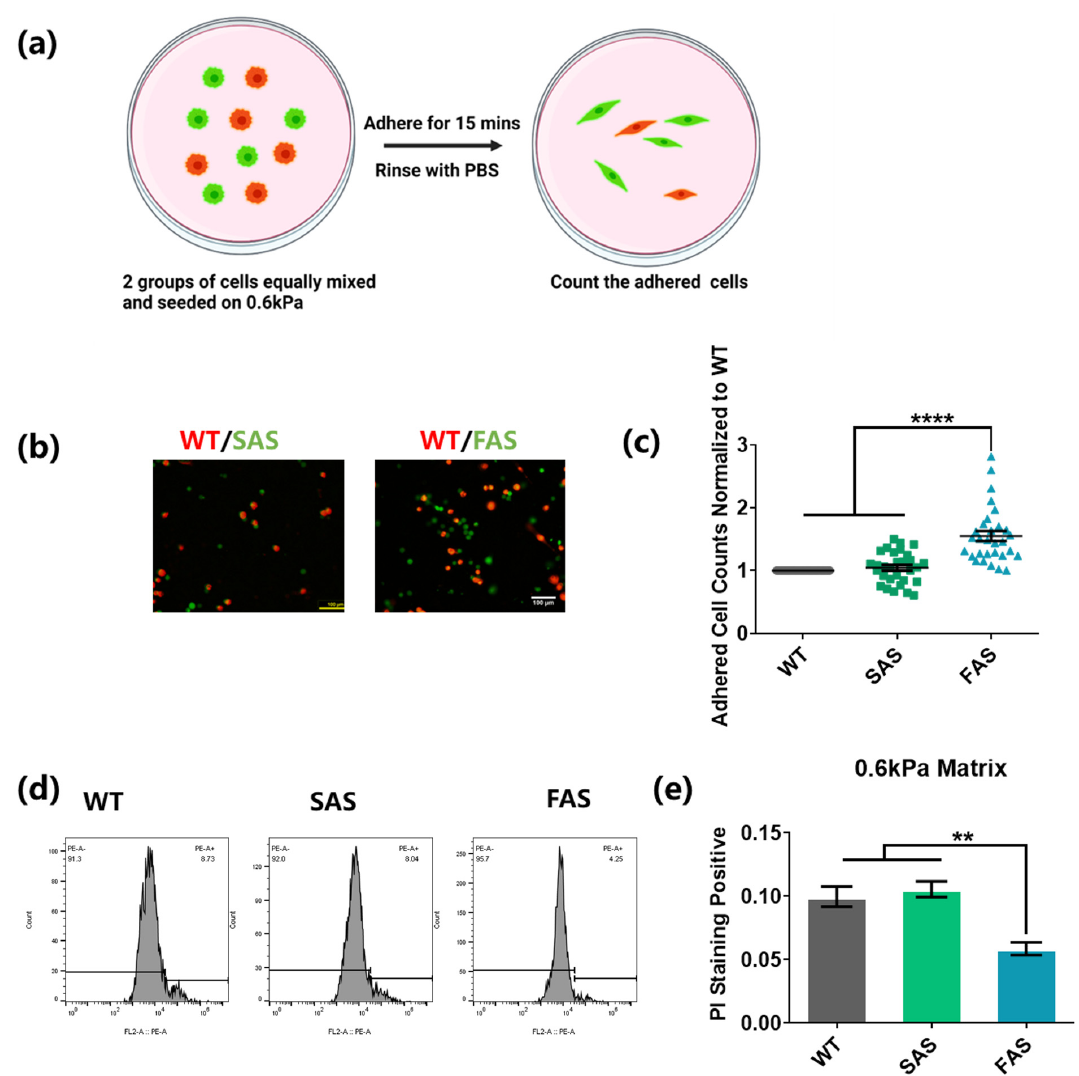
Figure 4. FAS cells exhibit advantages in cell adhesion and survival within the soft brain environment. ( a – c ) FAS cells had an enhanced adhesion ability on 0.6 kPa soft matrices. The same number of cancer cells from the WT group (labeled with red cell tracker) was mixed with cancer cells from the FAS group or the SAS group (labeled with green cell tracker) and seeded on the same 0.6 kPa polyacrylamide gels coated with collagen I. After 15 min, these cells were gently washed with PBS. This illustration was created using Biorender.com ( a ). The remaining cells were imaged and counted under fl uorescence microscope. Scale bar = 100 µm. n = 3. ( d , e ) FAS cells exhibited lower cell apoptosis on soft matrices. All groups were seeded on 0.6 kPa polyacrylamide gels coated with collagen I in low-FBS medium overnight. The dead cells were then marked with PI and tested through fl ow cytometry. n = 3. All data are represented by mean ± SEM. The statistics among three groups were calculated based on one-way ANOVA with the post hoc Bonferroni test. (** p < 0.01, **** p < 0.0001). To test their ability to adapt and survive in a soft brain environment, the morphology, survival, and prliferation of tumor cells were examined. FAS cells showed a much lower